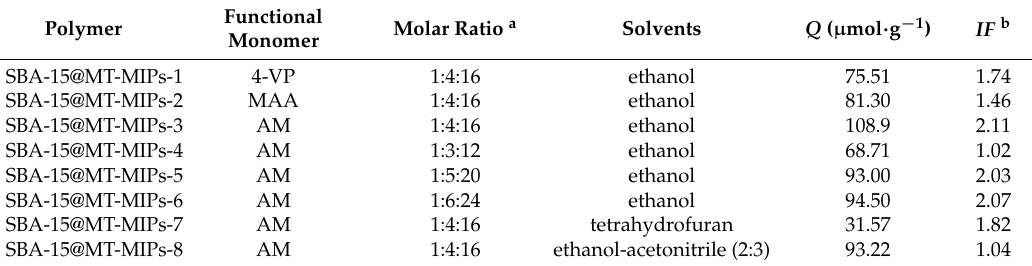
Table 1. The preparation of SBA-15@MT-MIPs under different conditions.